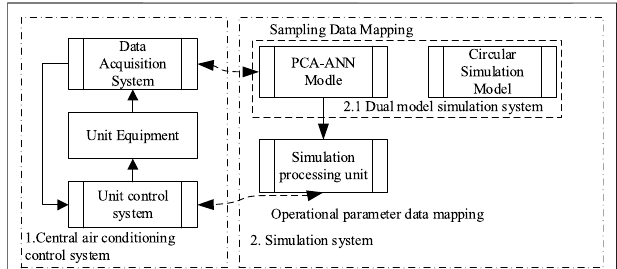
FIGURE 2 | The central air conditioning system ’ s simulation model